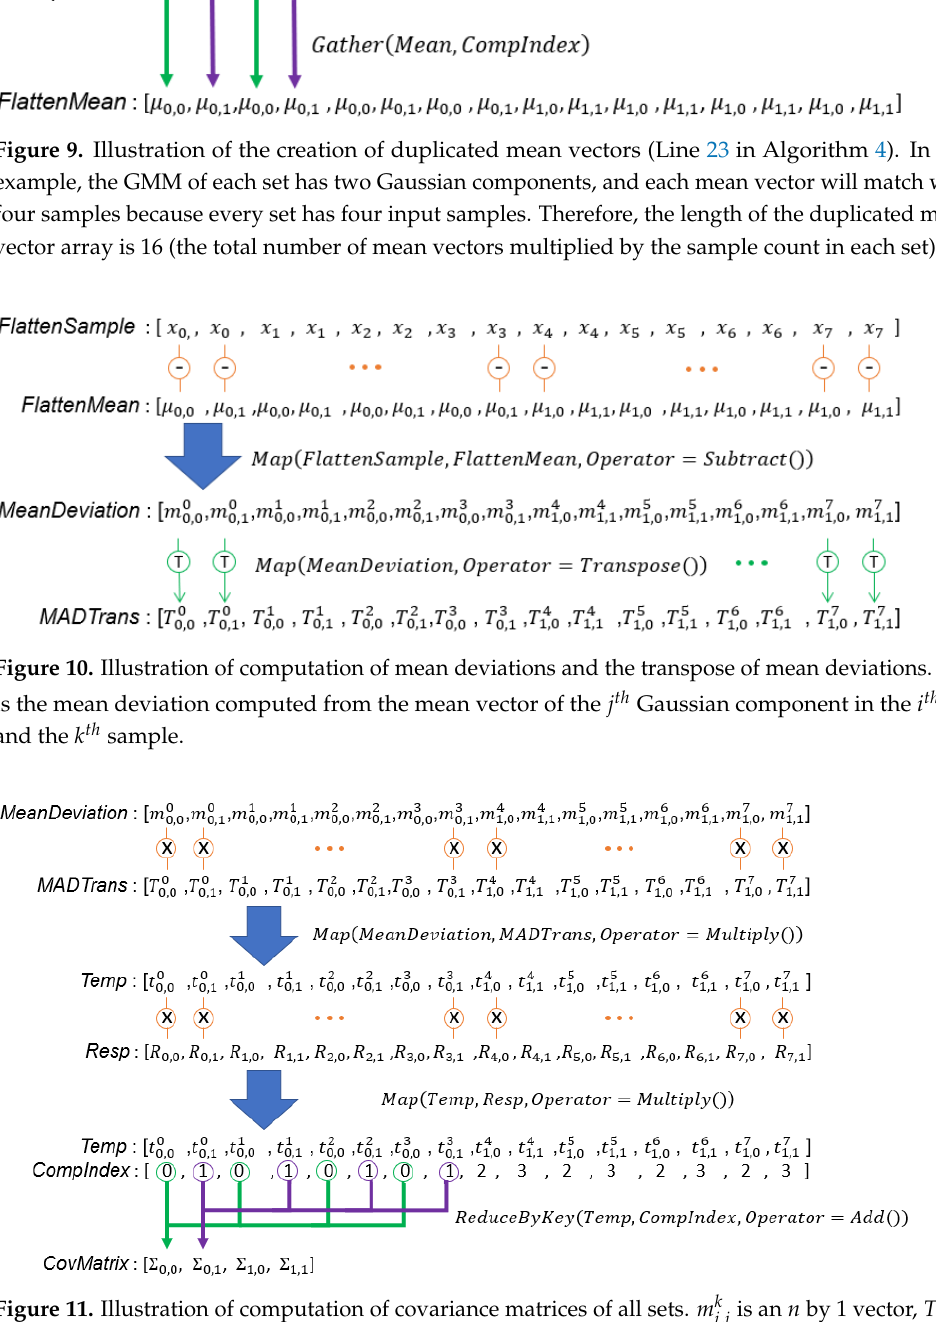
is an n by 1 vector, T k is i , j i , j